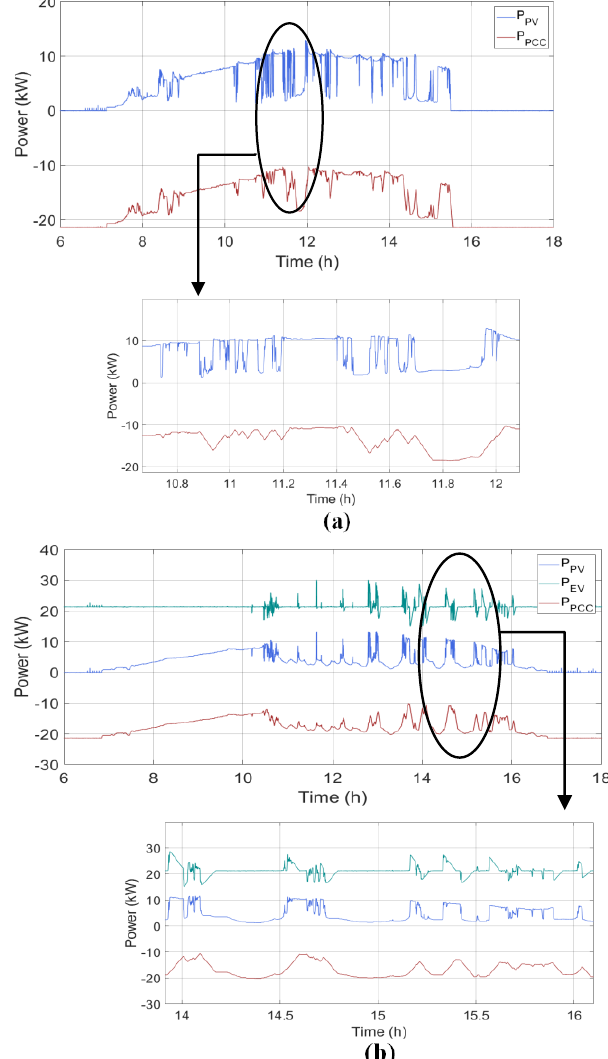
Figure 9. ( a ) Photovoltaic and injected power (most critical day); ( b ) photovoltaic, injected, and EV